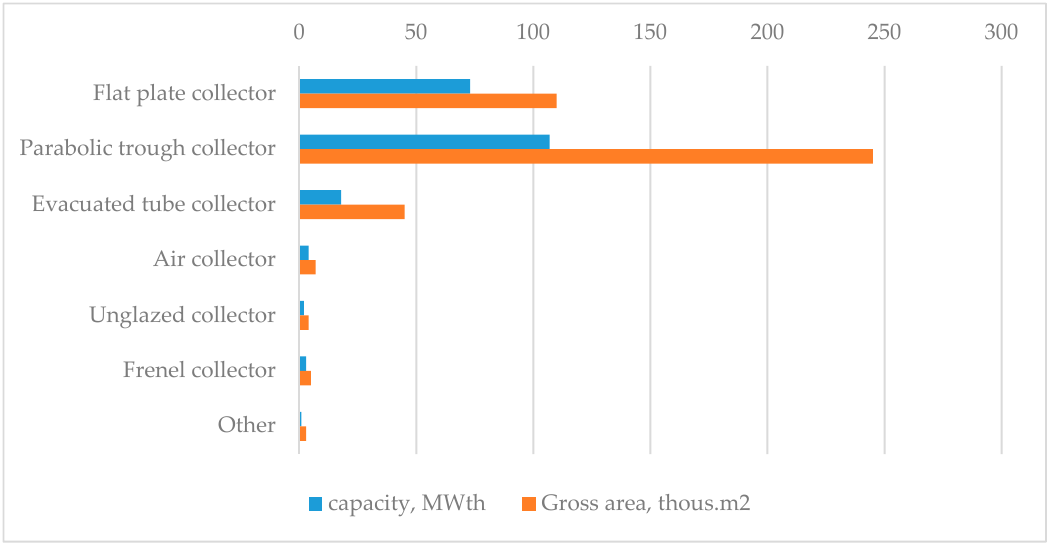
Figure 8. Distribution of industrial solar collectors by type [23].